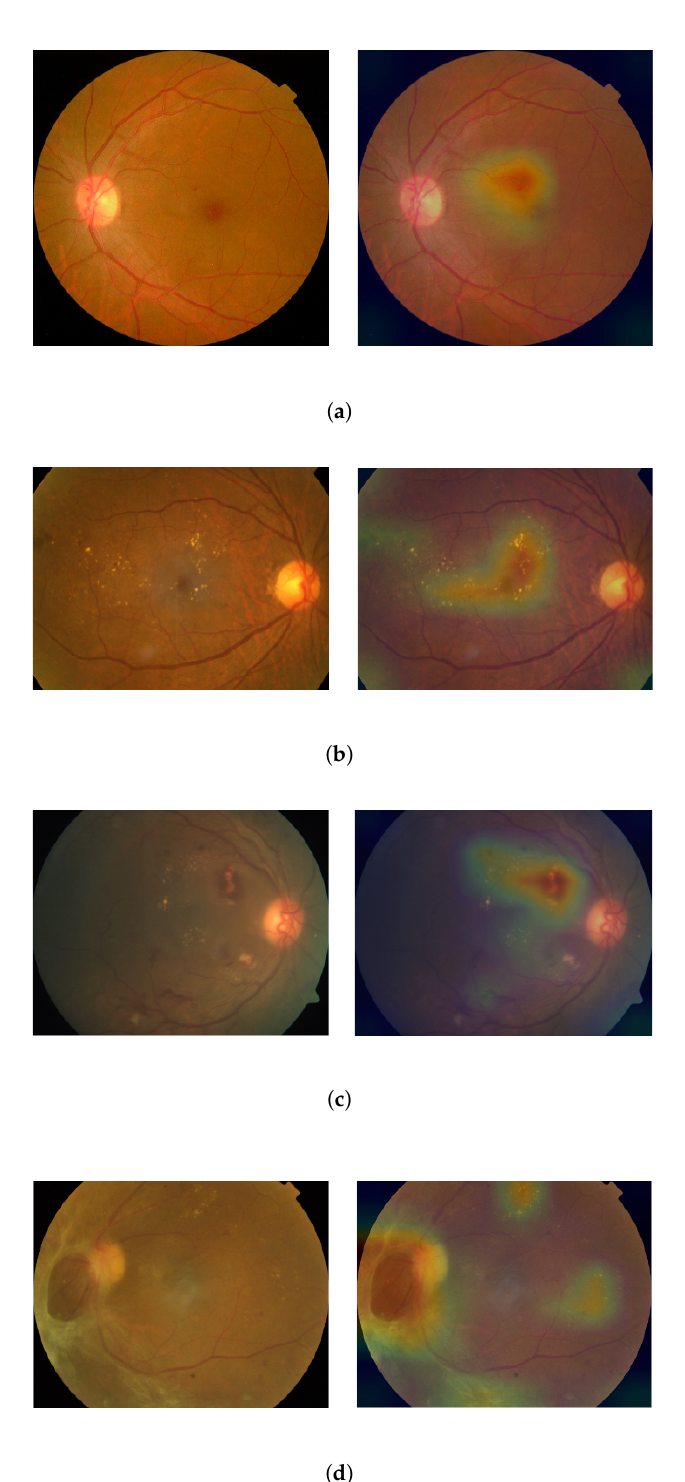
Figure 6. Qualitative analysis using heatmaps. ( a ) APTOS-mild NPDR. severity score: 1.12, predicted class: mild NPDR; ( b ) APTOS-moderate NPDR. severity score: 2.23, predicted class: moderate NPDR; ( c ) APTOS-severe NPDR. Severity score: 3.18, predicted class: severe NPDR; ( d ) APTOS-PDR. Severity score: 4.01, predicted class: